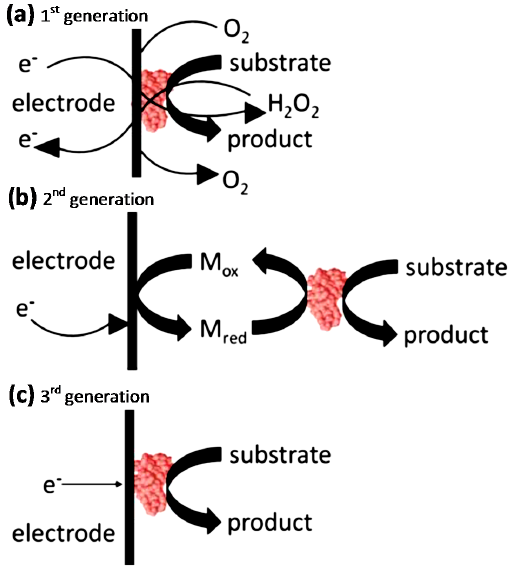
Figure 5. Schematic diagrams of three generations of sensors: ( a ) 1st generation; ( b ) 2nd generation and ( c ) 3rd generation [69].